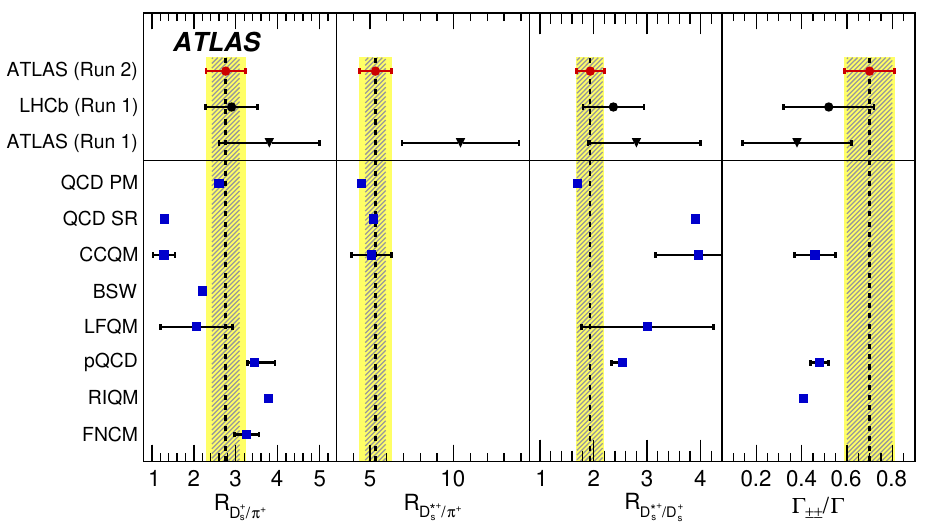
Figure 4 . Comparison of the results of this measurement with those of ATLAS Run 1 [2], LHCb [1] and theoretical predictions based on a QCD relativistic potential model (QCD PM) [3], QCD sum rules (QCD SR) [4], covariant confined quark model (CCQM) [6], Bauer-Stech-Wirbel relativistic quark model (BSW) [7], light-front quark model (LFQM) [8], perturbative QCD (pQCD) [9], re- lativistic independent quark model (RIQM) [10, 11], and calculations in the QCD factorization approach (FNCM) [12]. Hatched areas show the statistical uncertainties of this measurement and yellow bands correspond to the total uncertainties. Quadrature sums of all experimental uncer- tainties are quoted for the ATLAS Run 1 and LHCb results. The uncertainties of the theoretical predictions are shown only if they are explicitly quoted in the corresponding